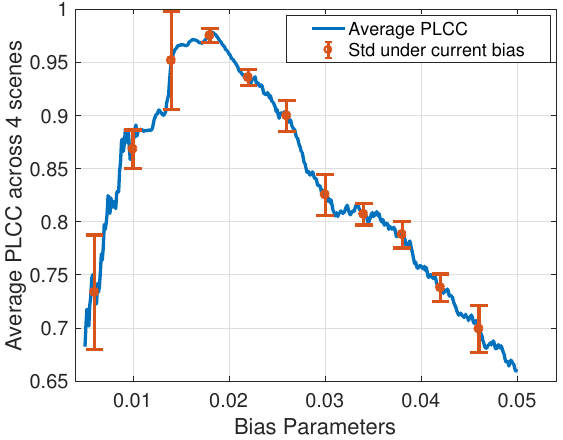
Figure 14. Average Pearson linear correlation coefficient (PLCC) values across four test scenes under different bias parameters and the standard deviations under different bias